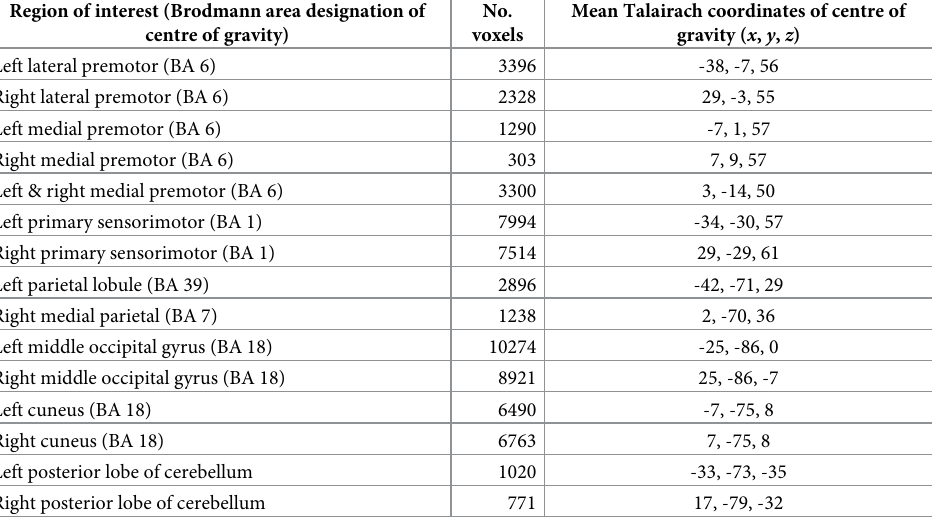
Table 1. Regions of interest localized across all